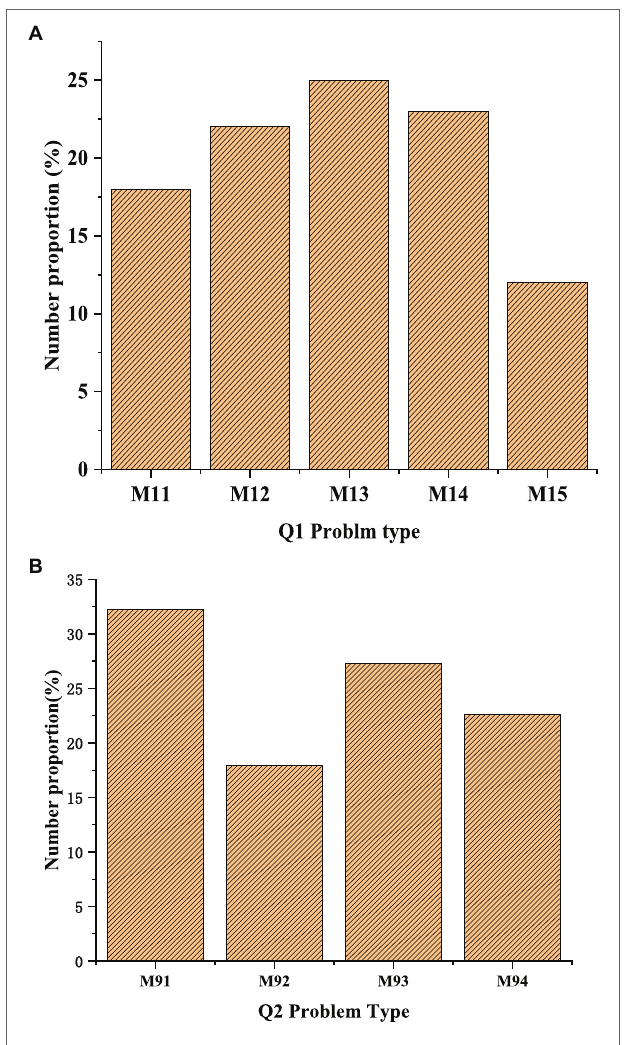
FIGURE 8 | Survey results based on Q1 and Q9: (A) the survey results based on Q1; (B) the survey results based on